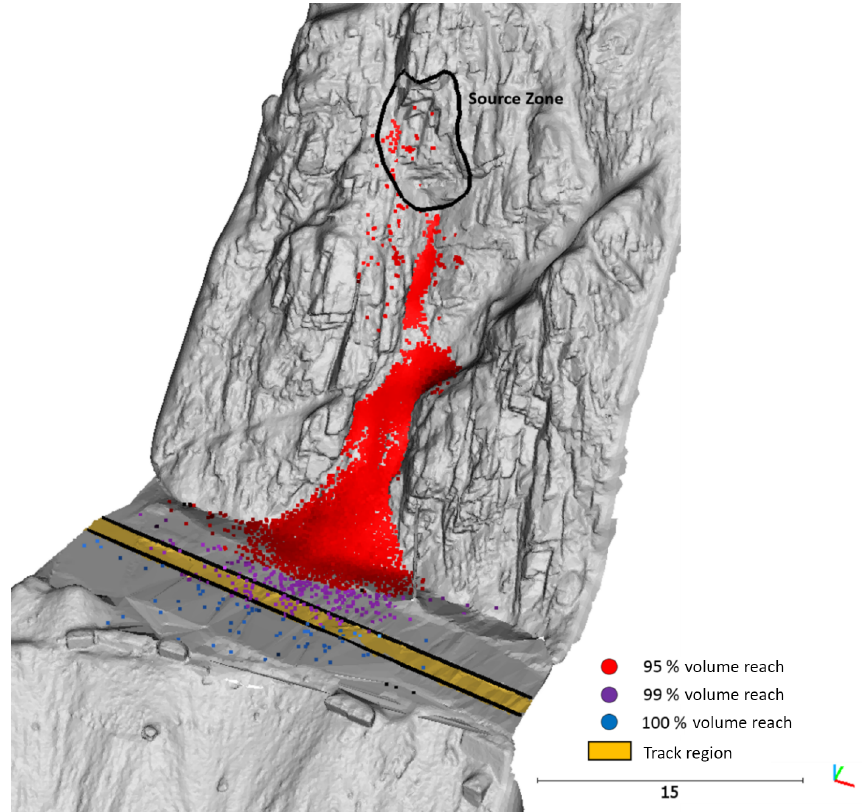
Figure 18. Results of the 15 simulations run for the 24m 3 wedge sliding event at White Canyon East, Site B. Each point represents the end point of a simulated fragment in one of the 15 simulations. The envelope of red points indicates the runout of 95% of the simulated volume, with the purple and blue portions representing envelopes containing the additional 4% and 1% of the material,